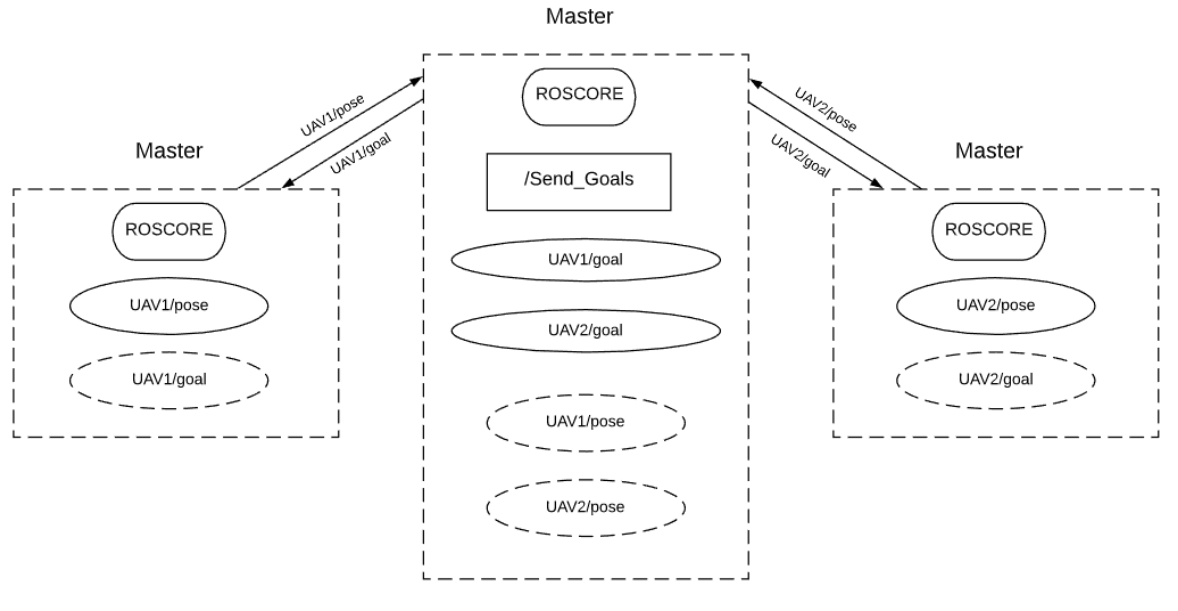
Figure 13. ROS general architecture of a multi-robot system, similar to the one presented in [34]. In this case, we show a fleet configuration with two UAVs; for larger fleets, the logic is the